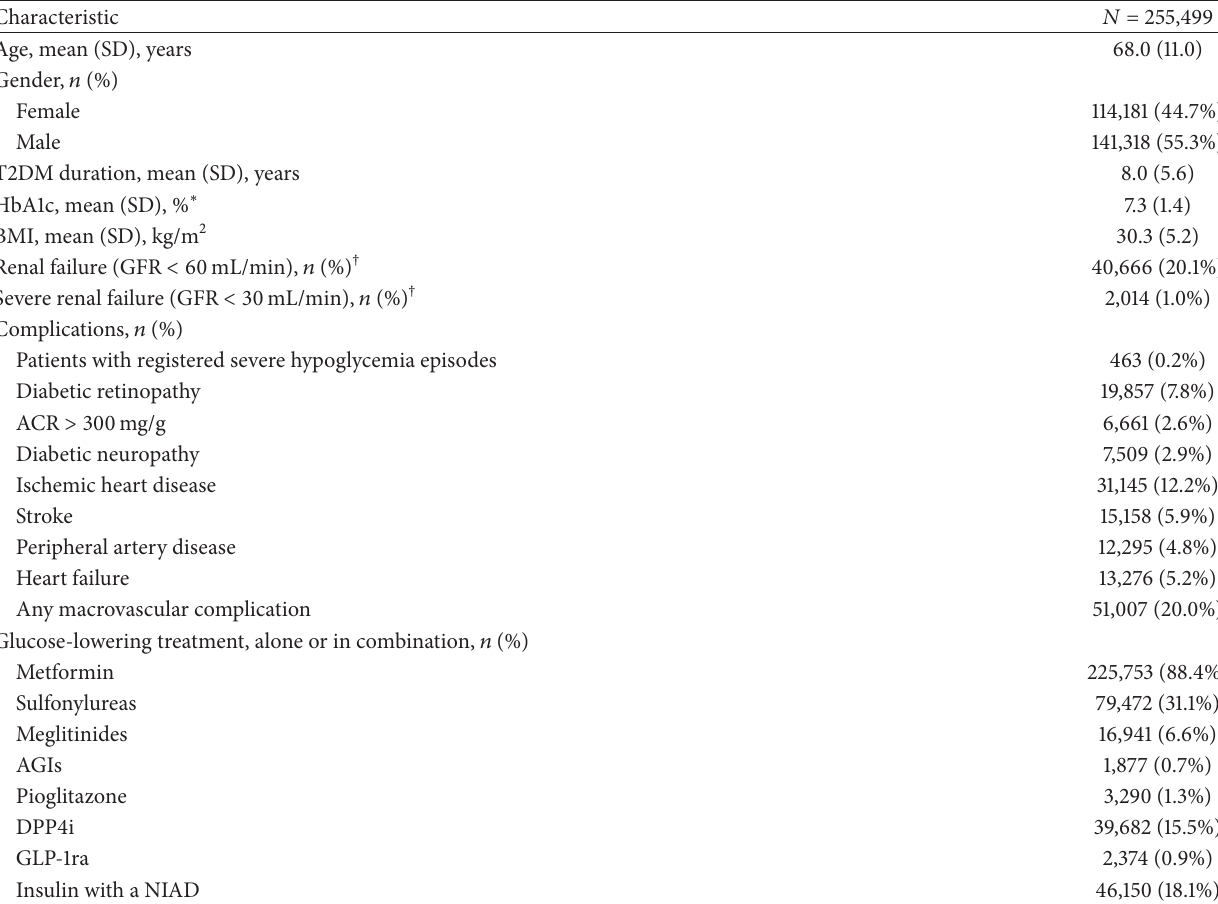
Table 1: Demographic and clinical characteristics of T2DM patients included in the